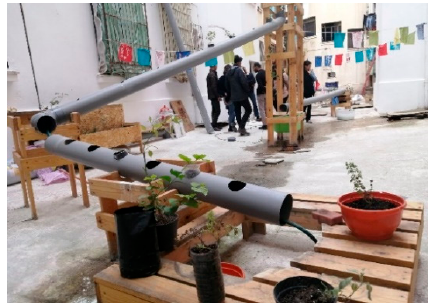
Figure 11. The UNESCO heritage site delimitation of Tunis Medina and the green spaces in the territory (data source: Authors).